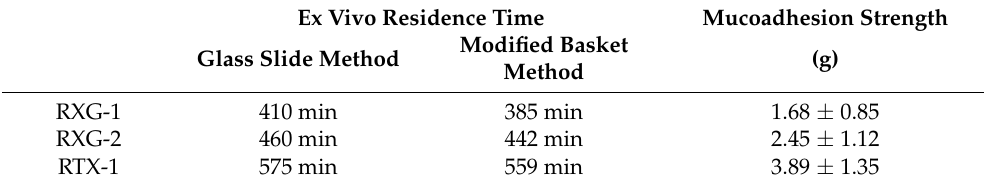
Table 7. Comparison of ex vivo mucoadhesion time and mucoadhesion